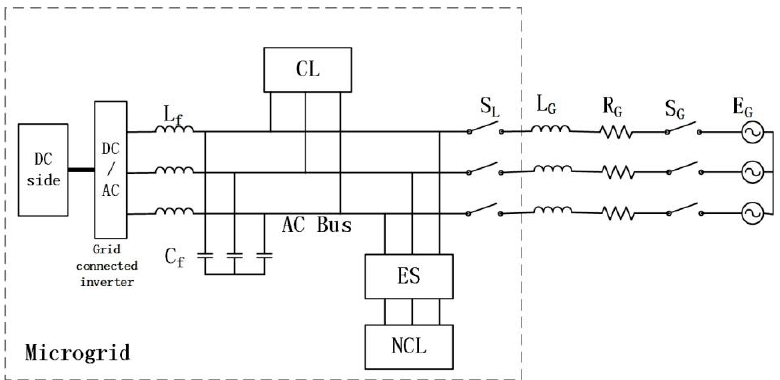
Figure 8. Microgrid system with electric spring.